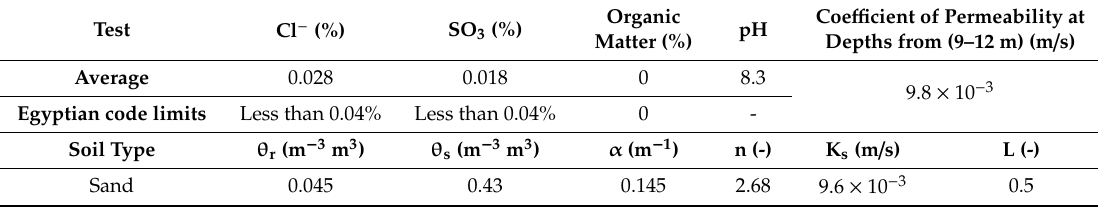
Table 5. Average tests result for soil samples collected from the pond area at depths from 9.0 to 12 m.